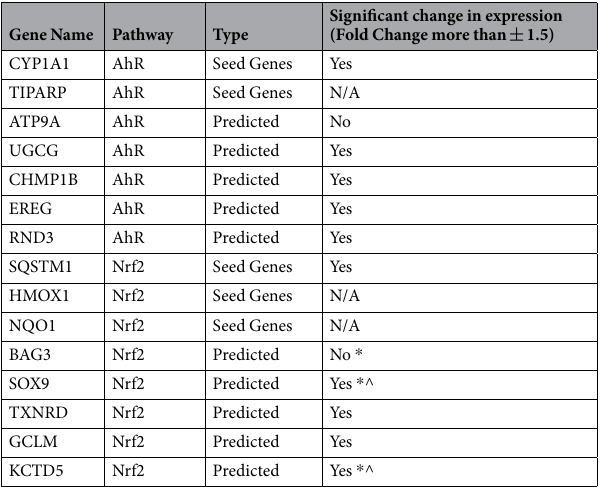
Table 4. Expression changes upon coffee exposure of genes identified using the DECA algorithm in AhR and Nrf2 pathways. ‘ * ’Indicates genes found to be significantly differentially expressed (Fold change > ± 1.5) in Turkish Coffee only. ‘^’Indicates genes found to be significantly differentially expressed (Fold change > ± 1.5) in Nescafe only. N/A indicates genes that were not the target of experimental validation. Genes were considered to be responsive if they were expressed in at least two coffee samples.